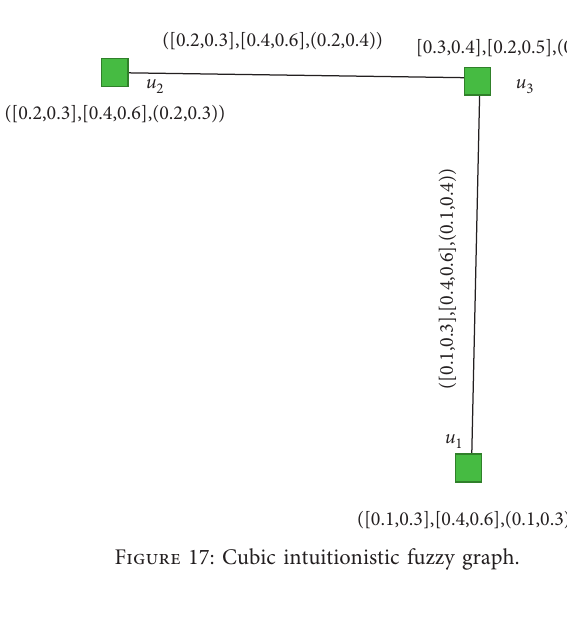
Figure 16: Cubic intuitionistic fuzzy